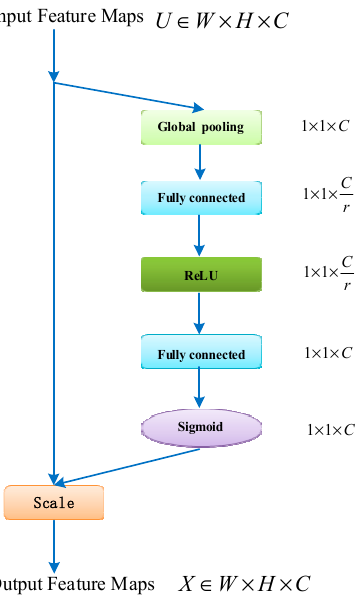
Figure 2. The structure of the Squeeze and Excitation (SE) module.